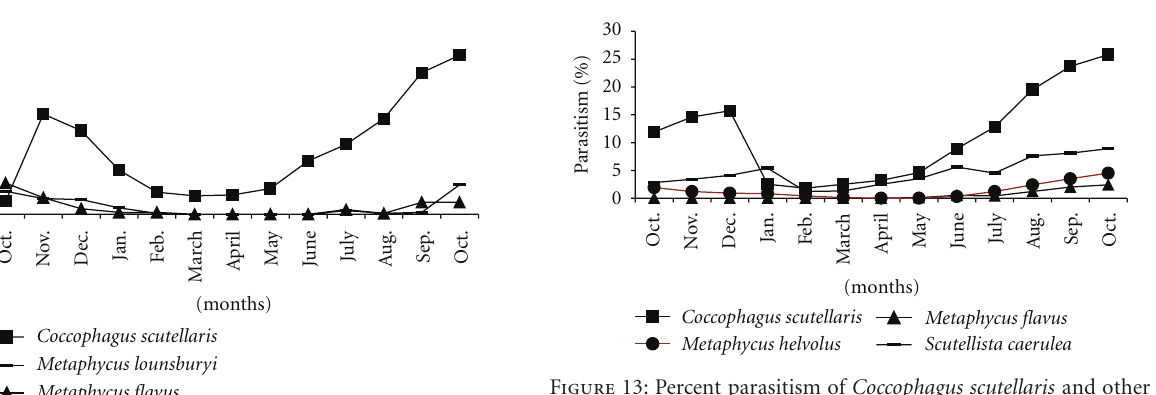
Figure 13: Percent parasitism of Coccophagus scutellaris and other associated parasitoids of Saissetia oleae on olive in Northern Coast governorate after releasing during 2009-2010.